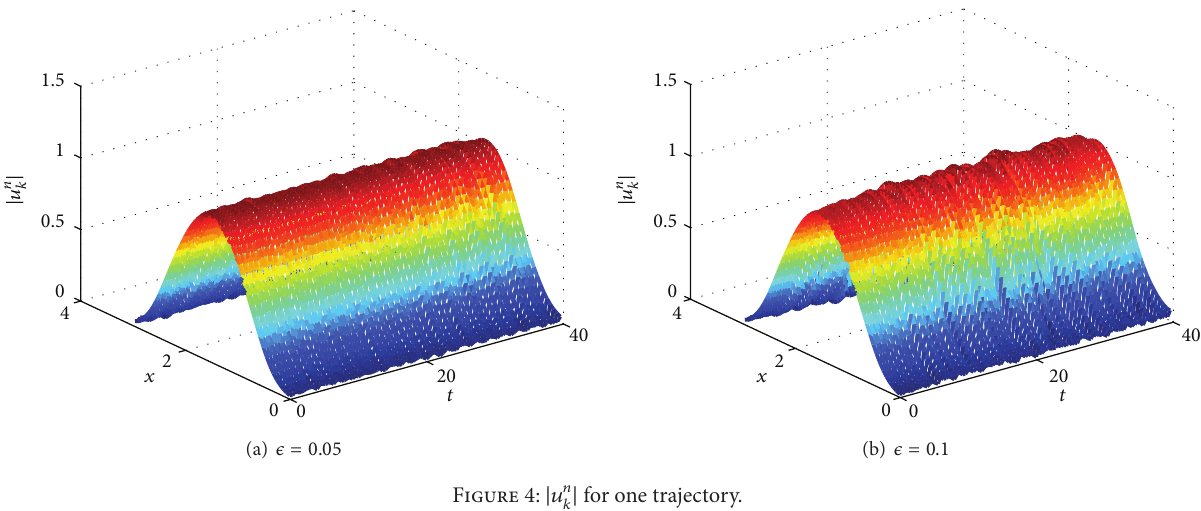
Figure 4: |𝑢 𝑛 𝑘 | for one